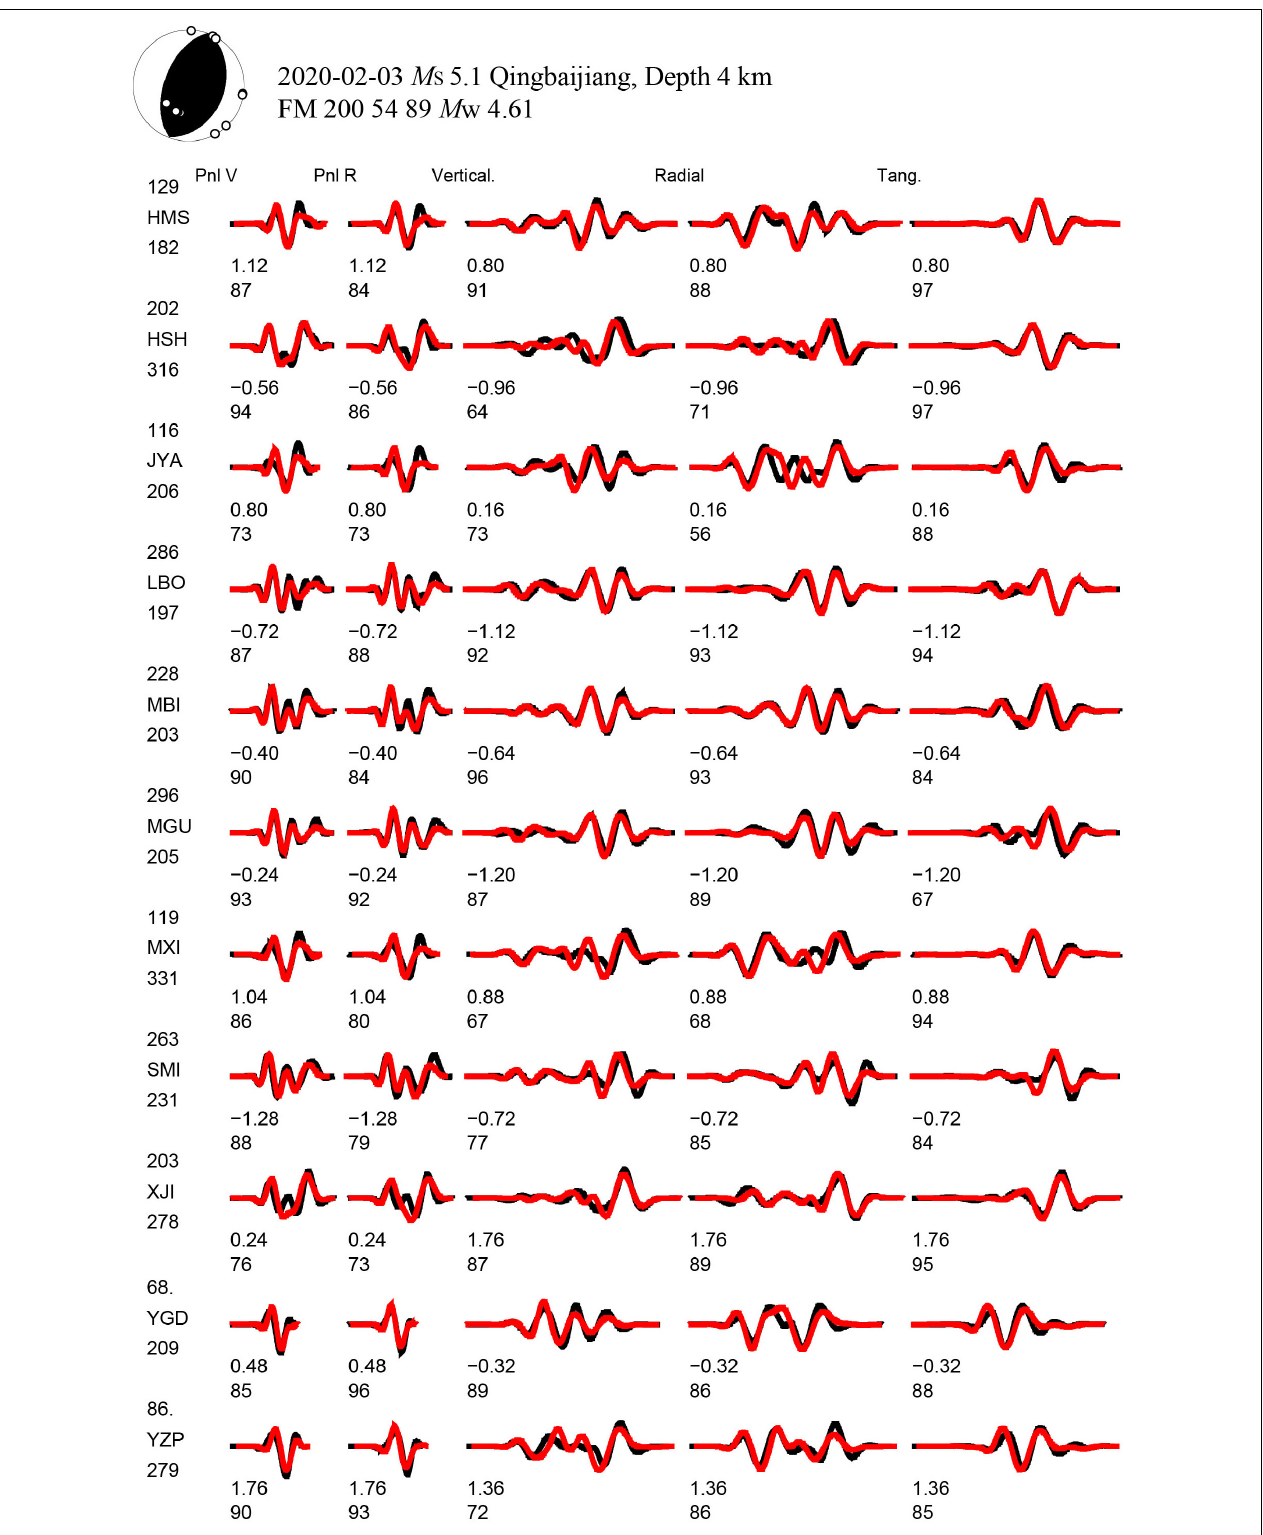
FIGURE 8 | Comparison of synthetic (red) and observed (black) waveforms at the best fitting depth for the M S 5.1 Qingbaijiang earthquake. The relative time shift (in s; upper) and correlation coefficient (in%; lower) are provided below each trace. The station names are given to the left, with the epicentral distance (in km; upper) and azimuth (in degree; lower)